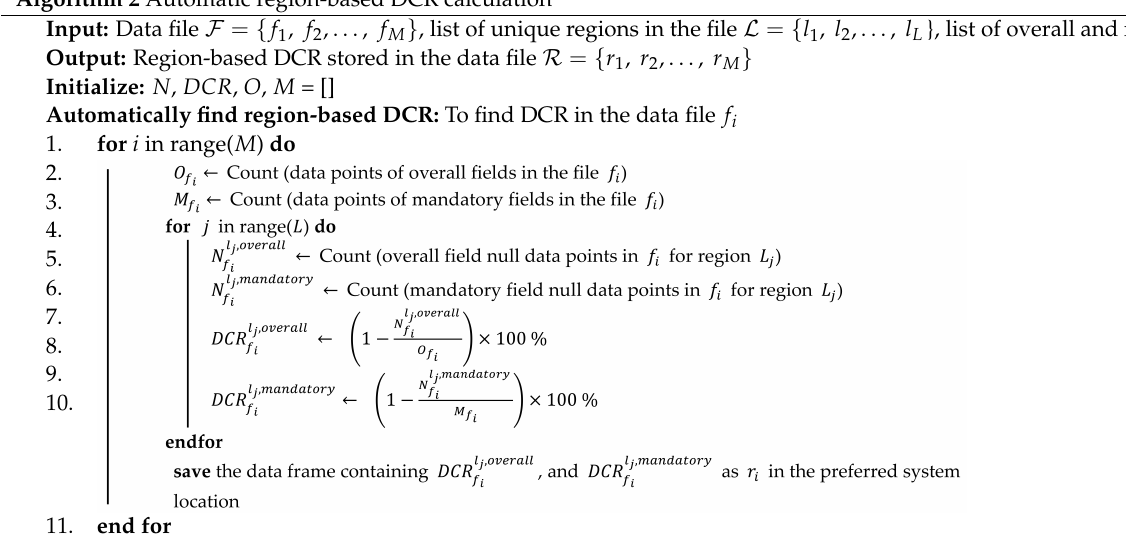
Algorithm 2 Automatic region-based DCR